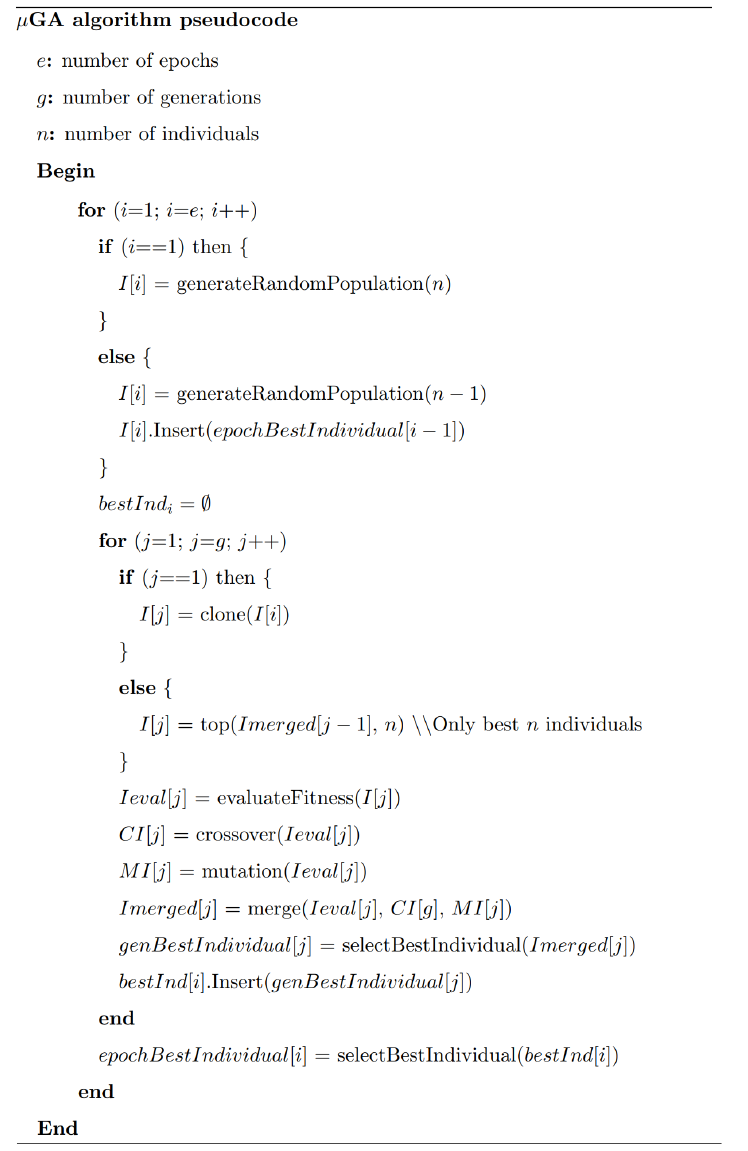
Figure A1. The pseudocode of the micro genetic